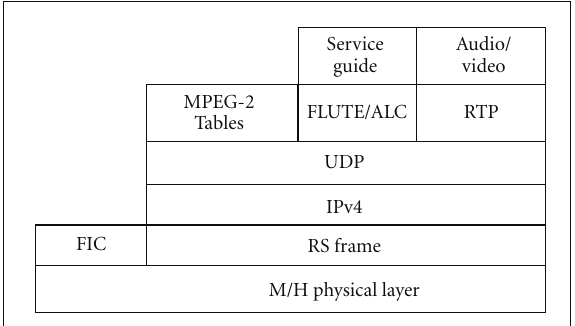
Figure 6: Simplified protocol stack for ATSC Mobile